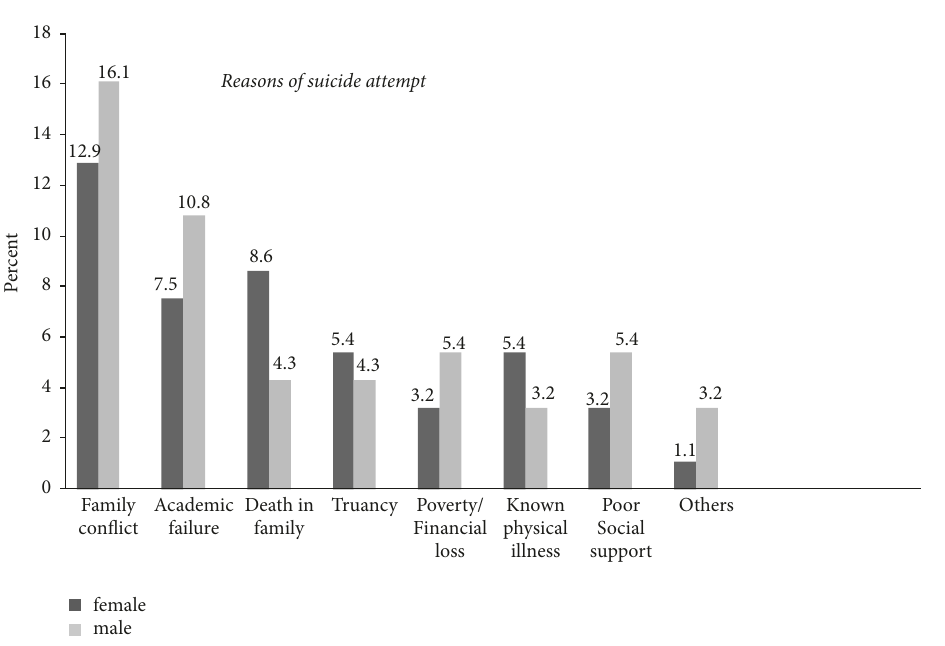
Figure 3: Reasons of lifetime suicide attempt among adolescent high school students in Dangila Town, Northwest Ethiopia,